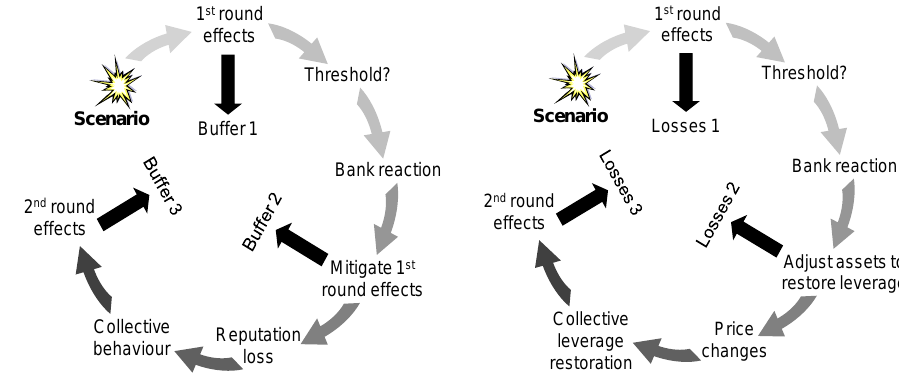
FIGURES 1 (left) and 2 (right): Illustrations showing the cycle of a liquidity event and stages where liquidity buffers may be affected. Buffer restoration and leverage